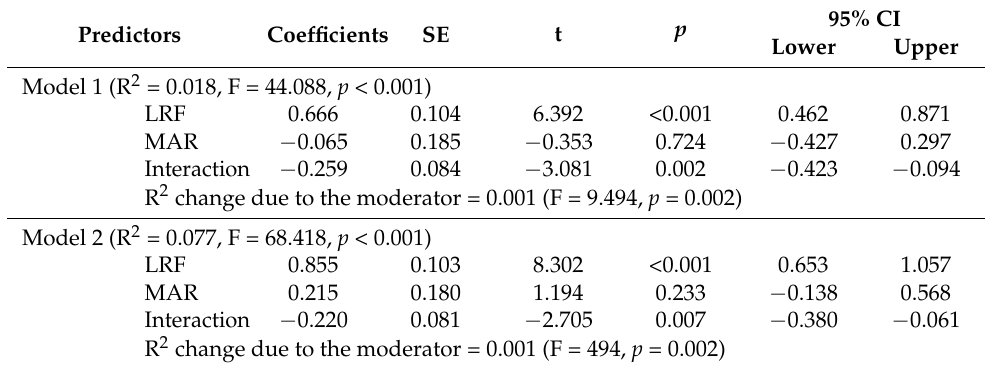
Table 4. Moderation analyses of mean adequacy ratio for the relationship of depression with lifestyle risk factors.